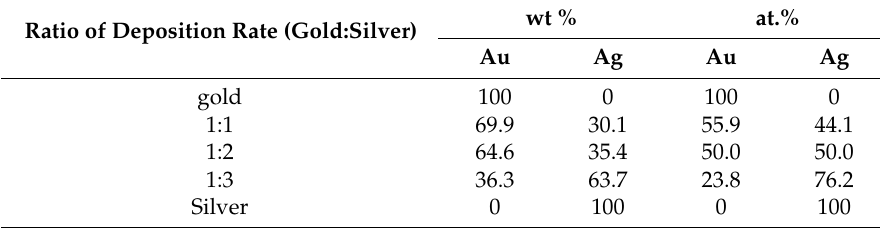
Table 1. The numerical EDS results of the double-metal complex